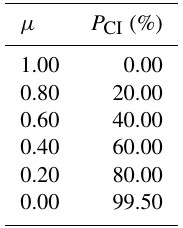
Table 2. Selected values for P CI for the FNN